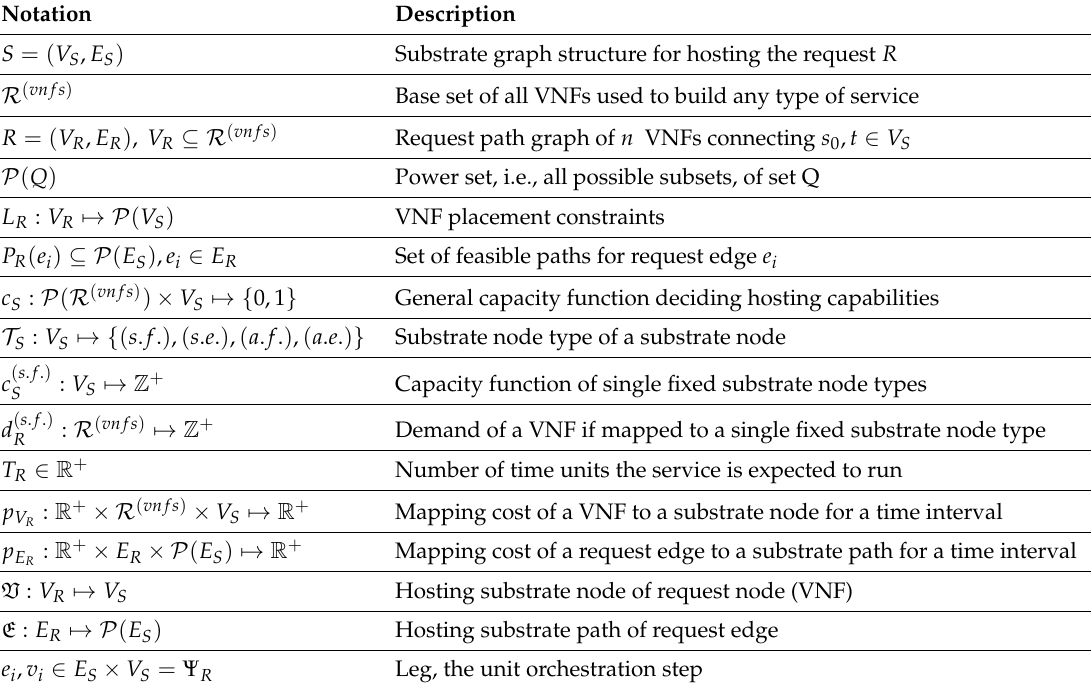
Table 2. Notations used in embedding algorithm description.